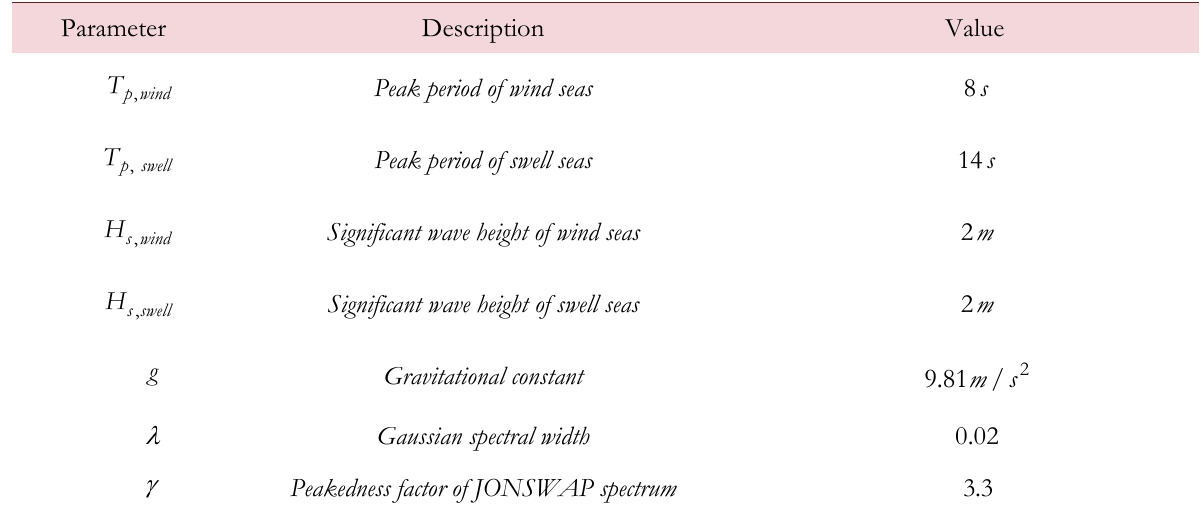
Table 4: All parameters which have been used to describe the two spectra of swell respectively wind